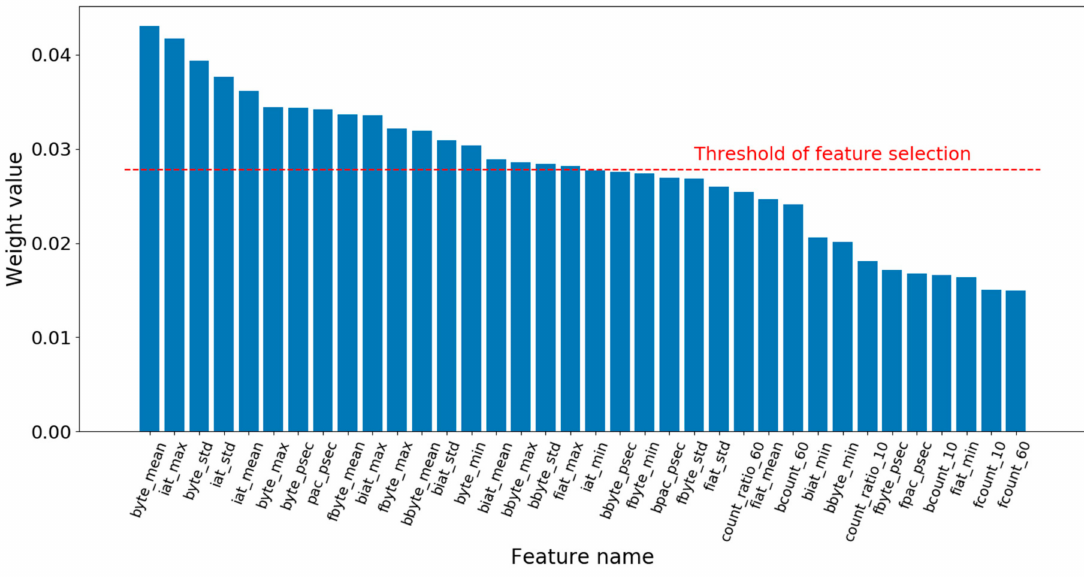
Figure 12. Comparison of feature weights in the feature selection part of model training for identifying content type of encrypted